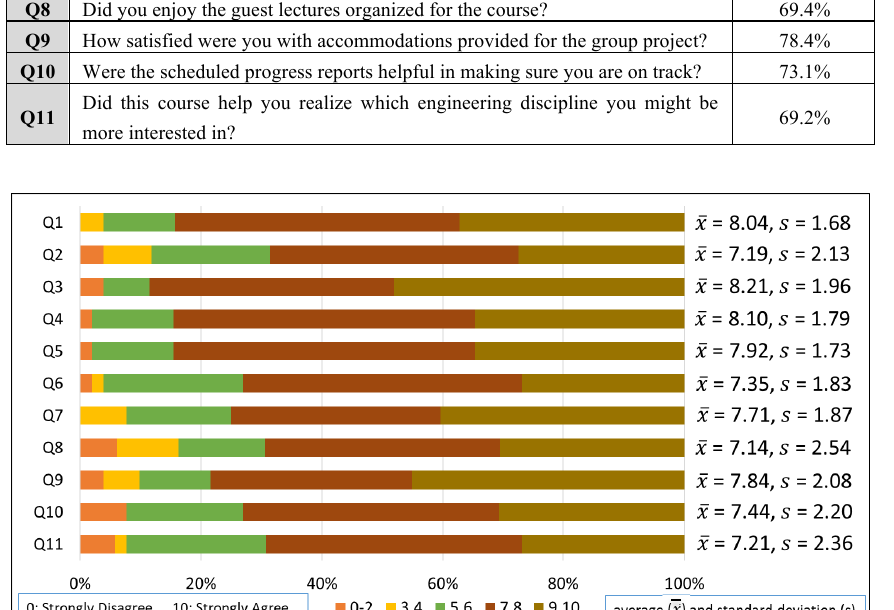
Fig. 6. Detailed survey